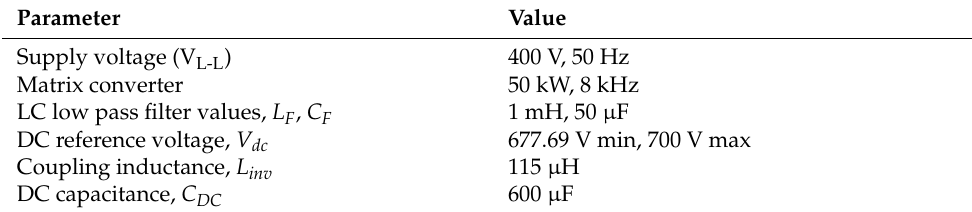
Table 3. Simulation